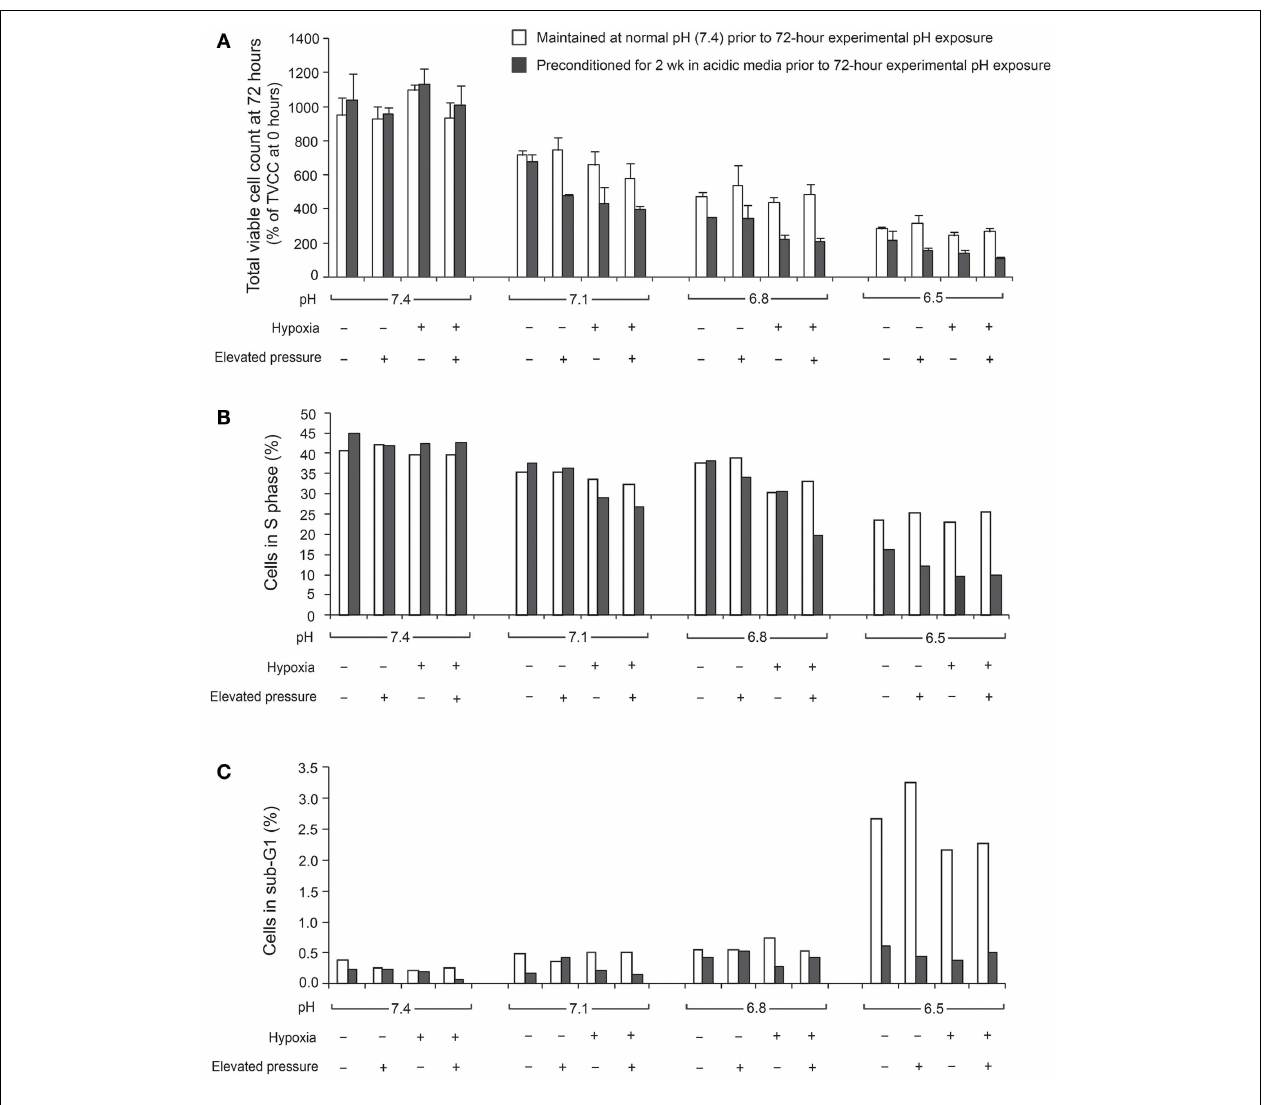
the “0h” time point in all studies. Net growth at 72h was expressed relative to the initial count at 0h (TVCC ratio). Cells were grown with and without a 2-week preconditioning phase in acidic medium prior to the experimental pH exposure